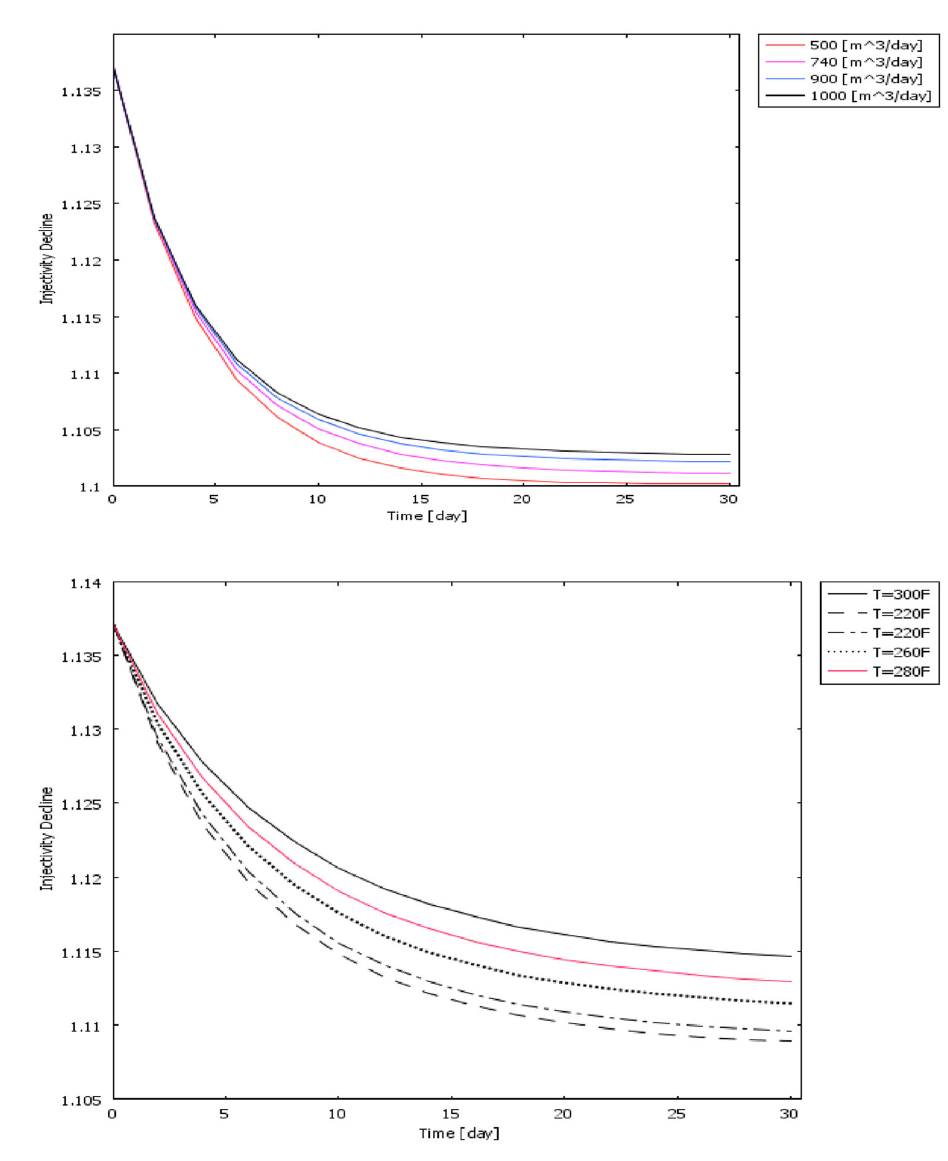
Fig. 17 Injectivity with time at different rates